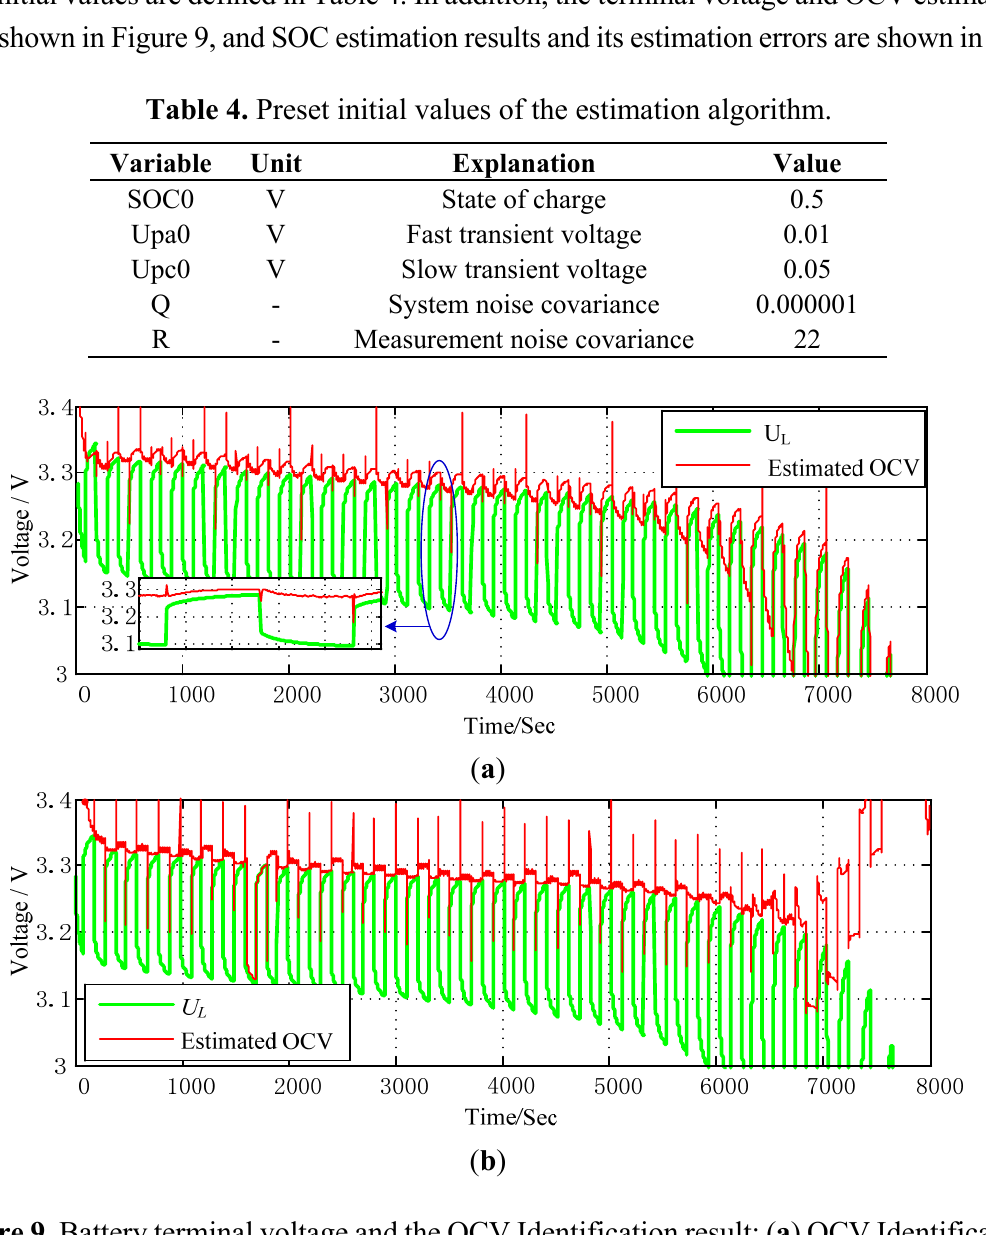
Figure 9. Battery terminal voltage and the OCV Identification result: ( a ) OCV Identification result using a specific set of model parameters; ( b ) OCV Identification result using “approximate online” model parameters identification